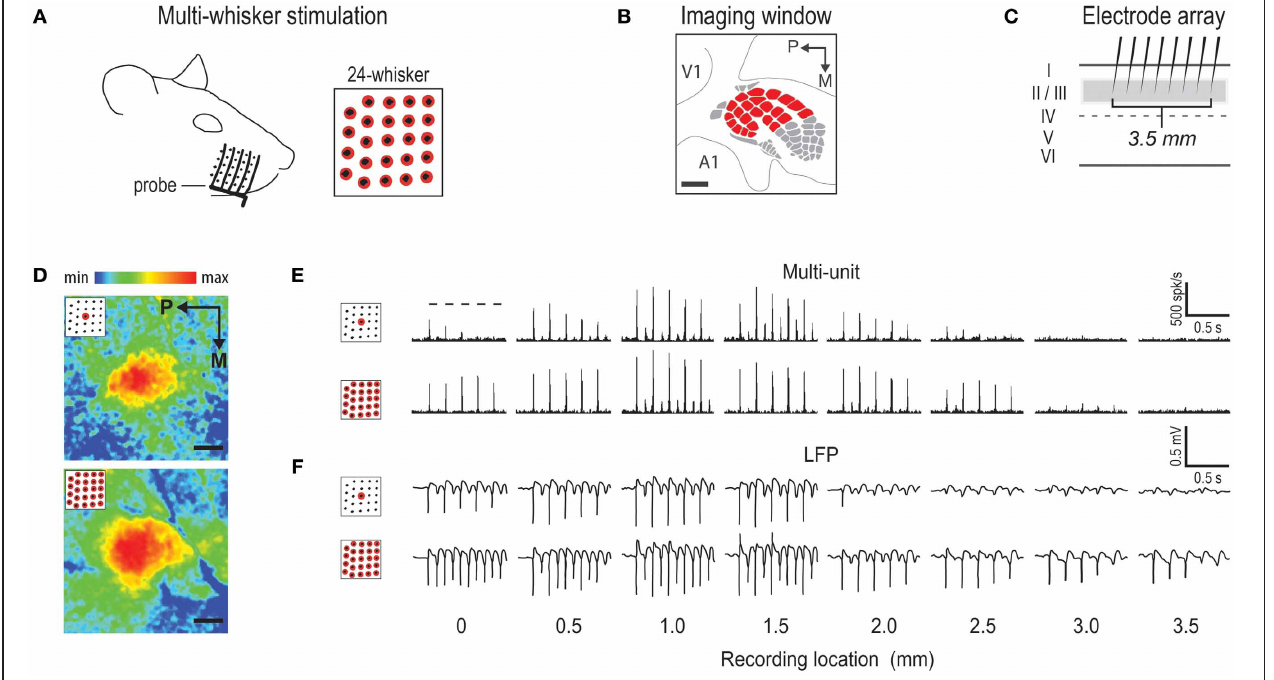
FIGURE 2 | Representative cases of rat barrel cortex response to stimulating an array of 24 whiskers. (A) 5-prong probe used to achieve multi-whisker stimulation. Stimulated whiskers are indicated in red. (B) 6 × 6mm intrinsic signal optical imaging field-of-view used when imaging activity simultaneously from the entire barrel cortex plus surrounding regions. V1 = primary visual cortex; A1 = primary auditory cortex. (C) Array of eight independently positioned electrodes, spaced 0.5mm apart, used to record supra- and sub-threshold neuronal activity from cortical layers II/III. (D) Representative cases of imaging activity for C2 whisker (top) versus